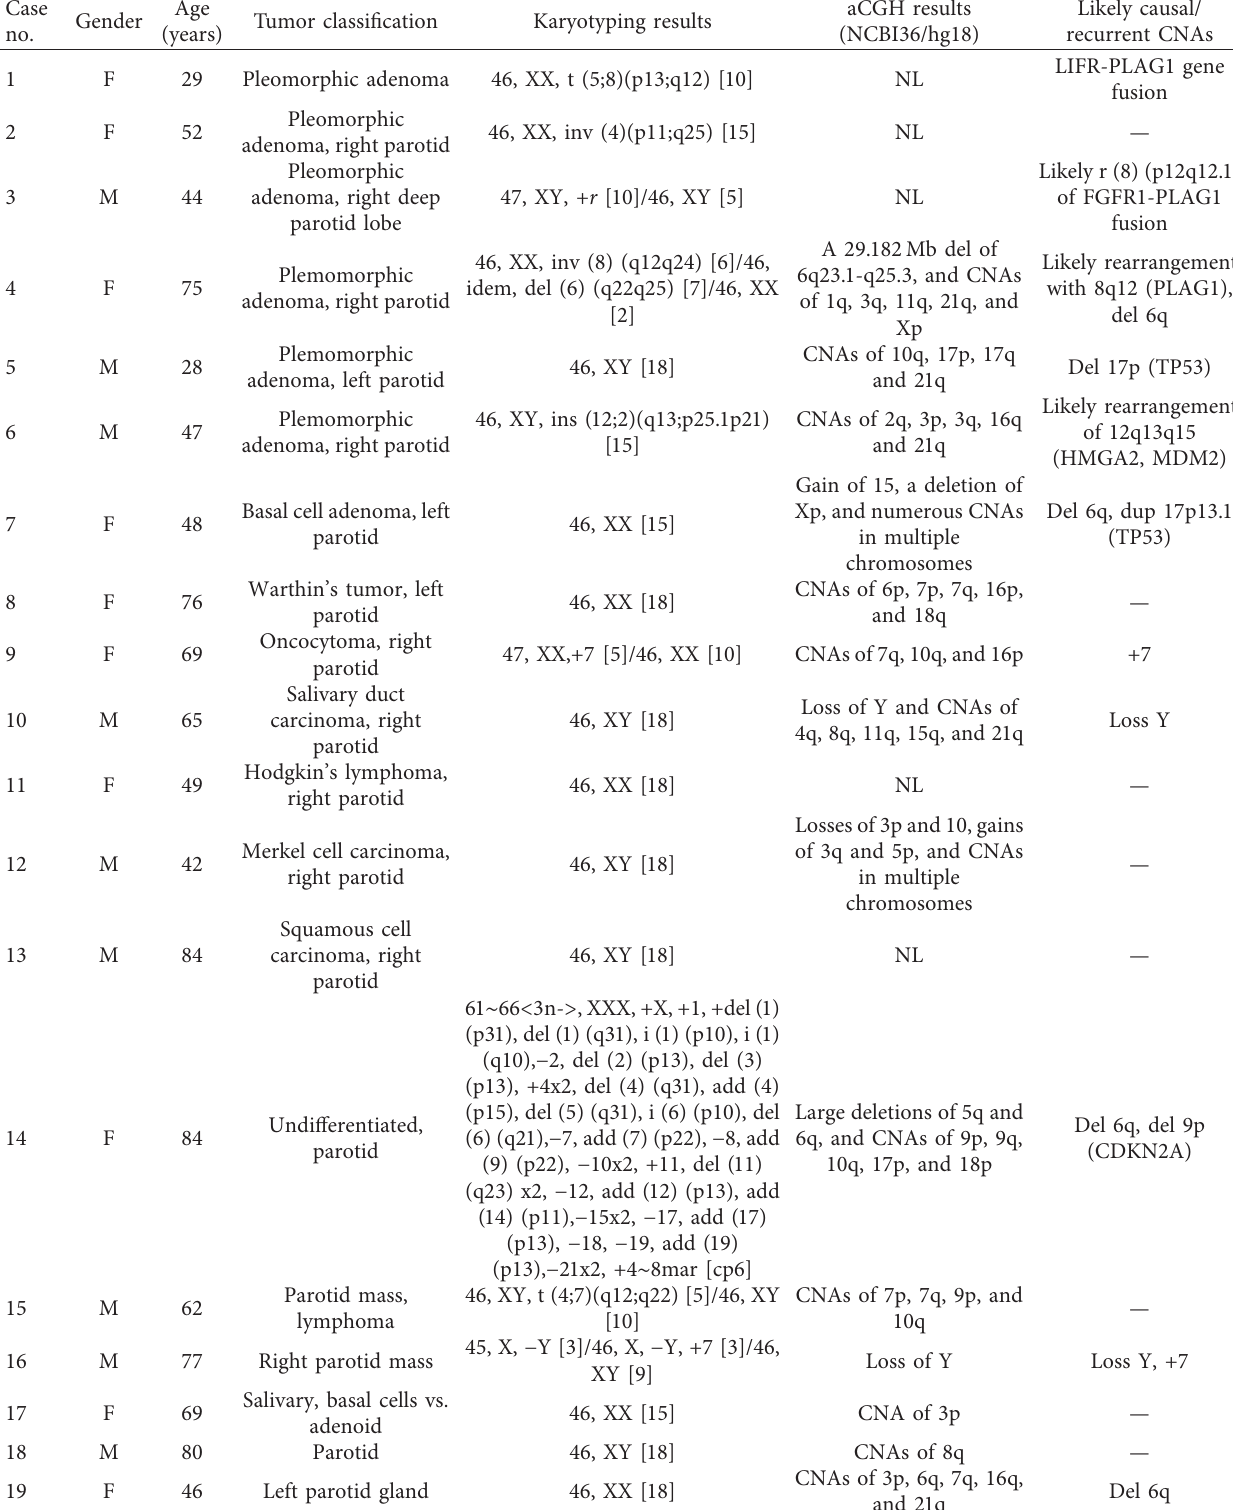
Table 1: Cytogenomic abnormalities detected in the nineteen